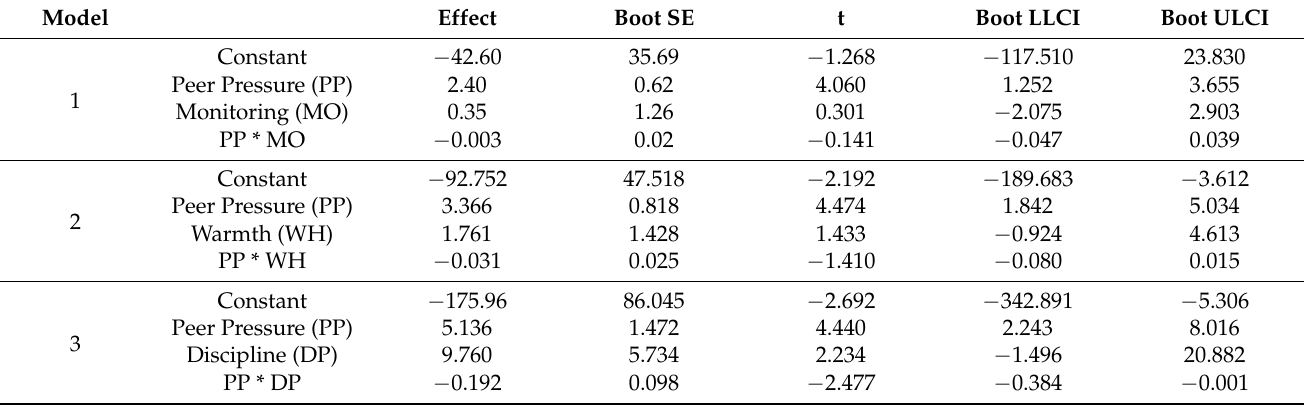
Table 5. Moderating role of child-rearing practices in the relationship between peer pressure and sexual adventurism.